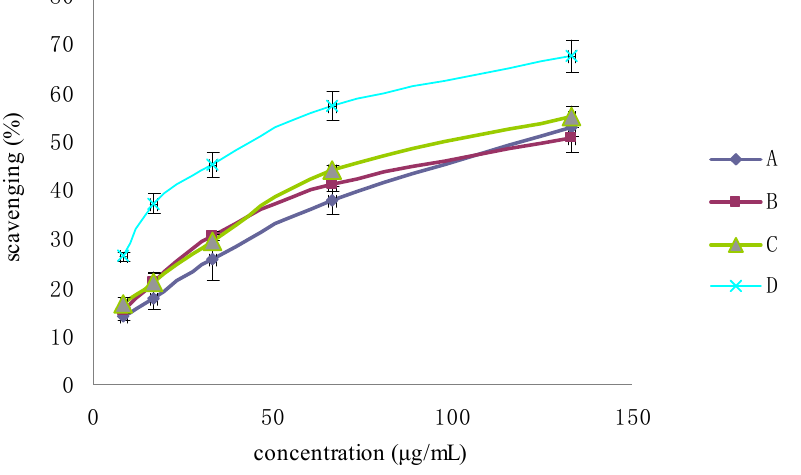
Figure 14. Superoxide radical-scavenging activity of Fuco stereoisomers. ( A ) (all- E )-Fuco; ( B ) 9' Z -Fuco; ( C )13 Z - and 13' Z -Fuco; ( D ) VE.